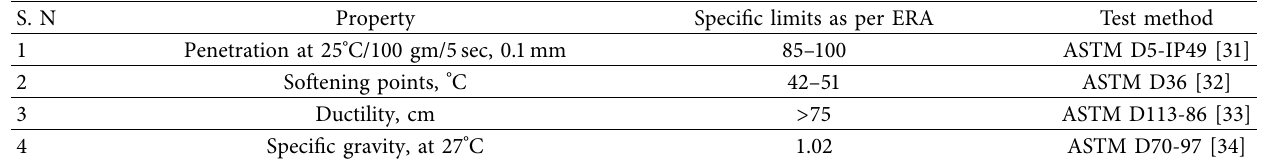
Table 5: Physical Properties of 85/100 grade bitumen.